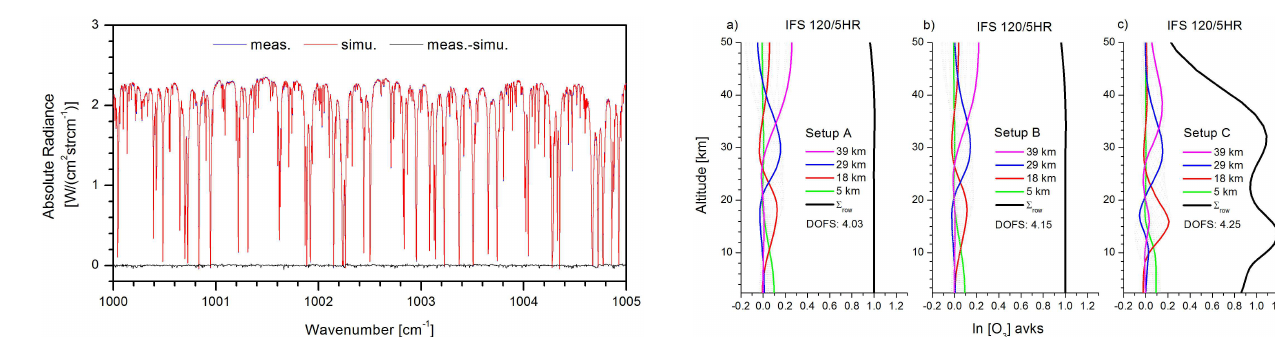
ozone values using the setup A (a) , setup B (b) , and C (c) , expressed as ln[O 3 ], for the Iza˜na IFS 120/5HR. 6 row (black line) is the total sensitivity of FTIR system and DOFS are the degrees of freedom for